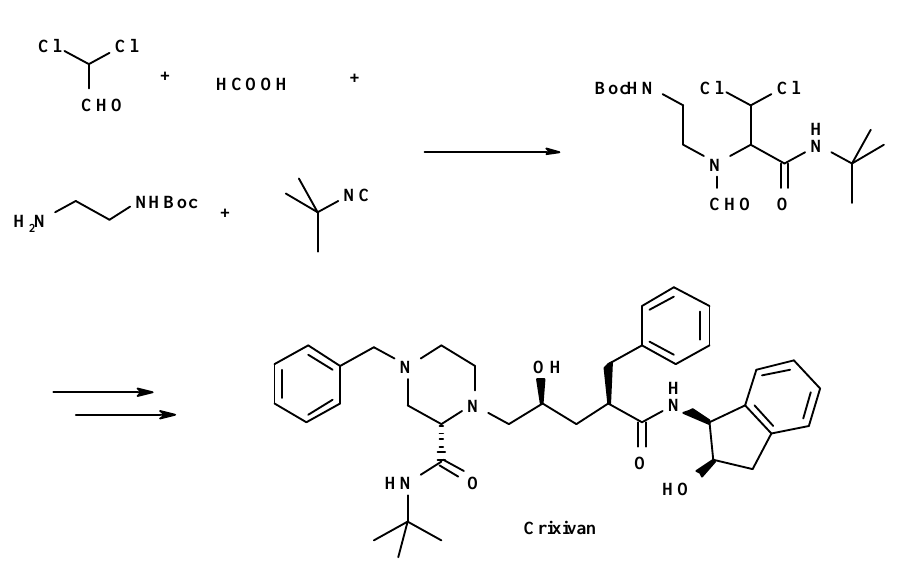
Scheme 12: The synthesis of Crixivan (MK 693) involving an